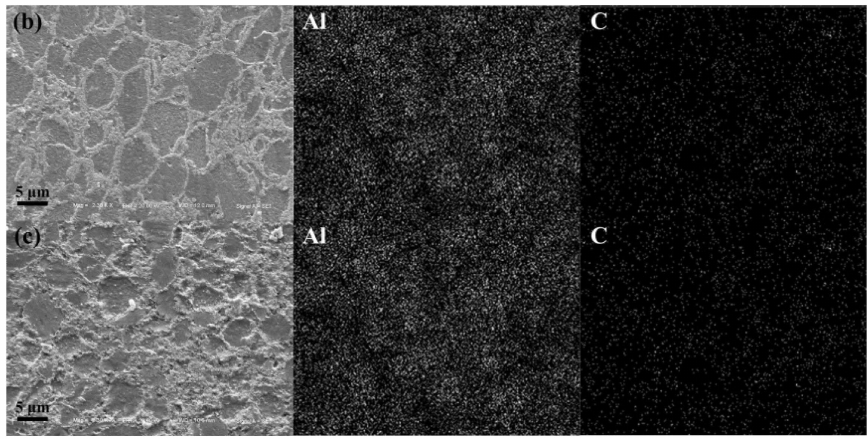
Figure 6. SEM-EDS analysis of the sintered composites that were ball milled for 24 h with different power sizes. ( a ) 20 µ m; ( b ) 9 µ m; ( c ) 5 µ m.